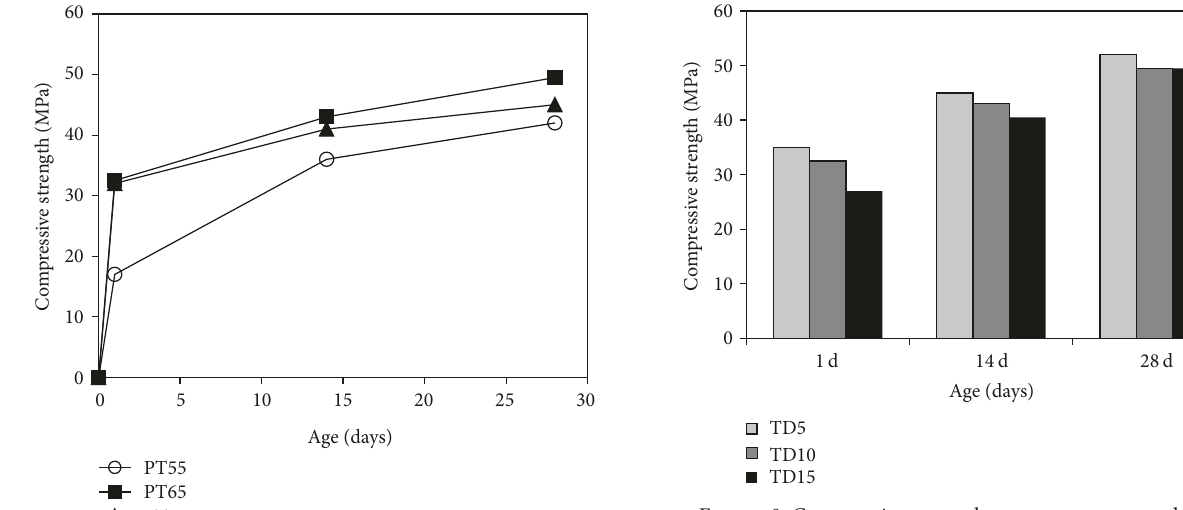
Figure 8: Compressive strength versus temperature